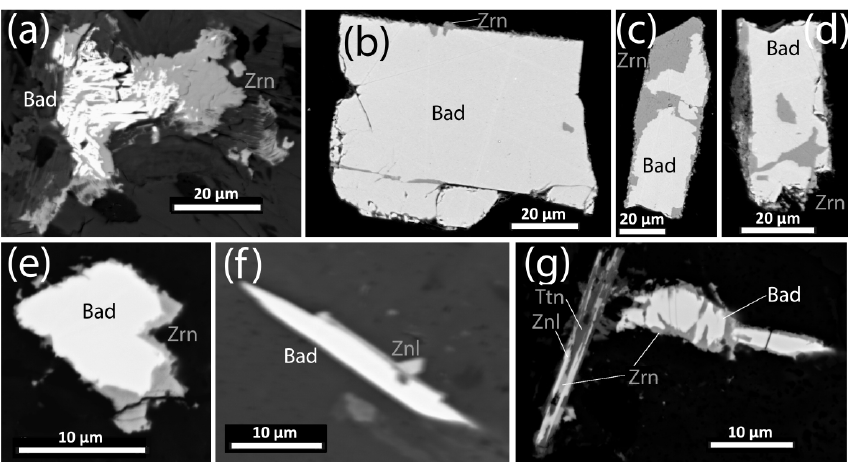
Figure 3. Backscatter electron (BSE) images of accessory minerals in the SEIC. (a) Baddeleyite (Bad) clusters surrounded by zircon (Zrn) from sample FP1F. (b–d) Mineral separates of baddeleyite from sample FP6D, showing variable proportions of zircon domains. (e) Baddeleyite with thin zircon rims from sample FP7G. (f) Baddeleyite–zirconolite (Znl) intergrowth from sample FP7G. (g) Baddeleyite and zirconolite surrounded by zircon and titanite (Ttn).